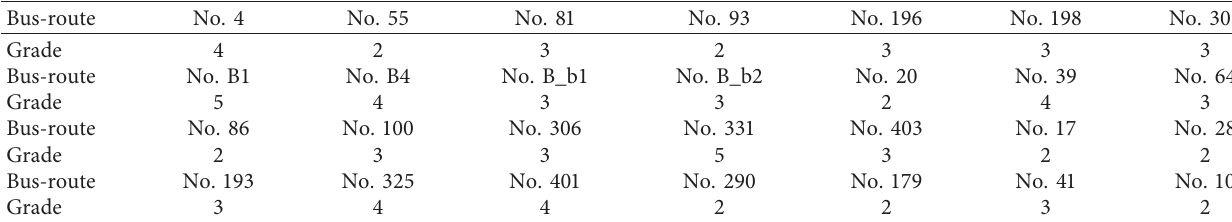
Table 6: Improved T-S fuzzy neural-network evaluation of bus-line speed grade.